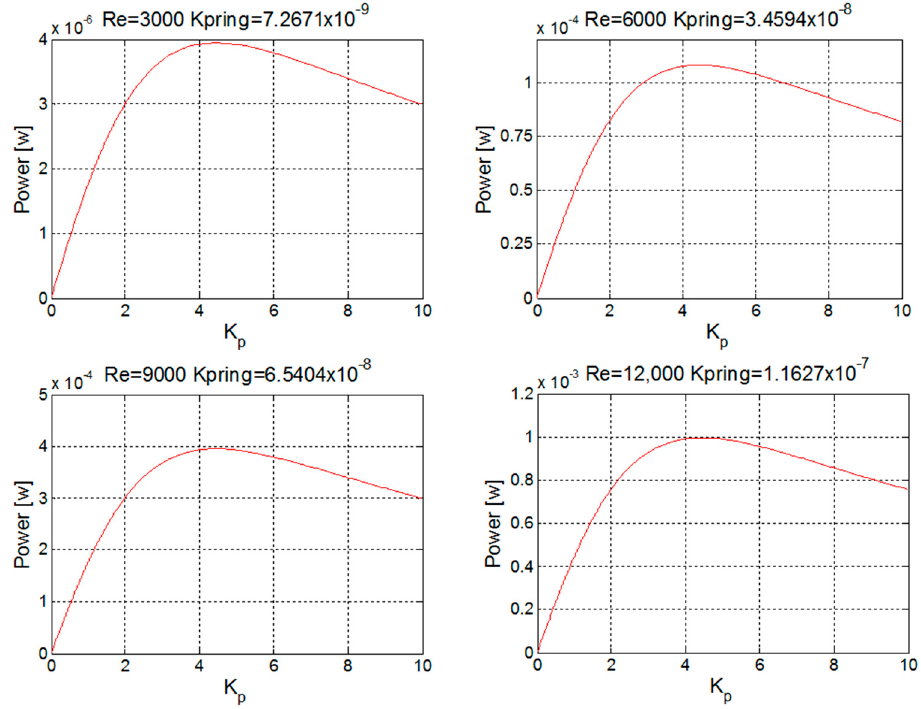
Figure 9. Power results along the proportional gain of the control law K p for different Reynolds numbers. The optimal K spring is also dented for each Re case.